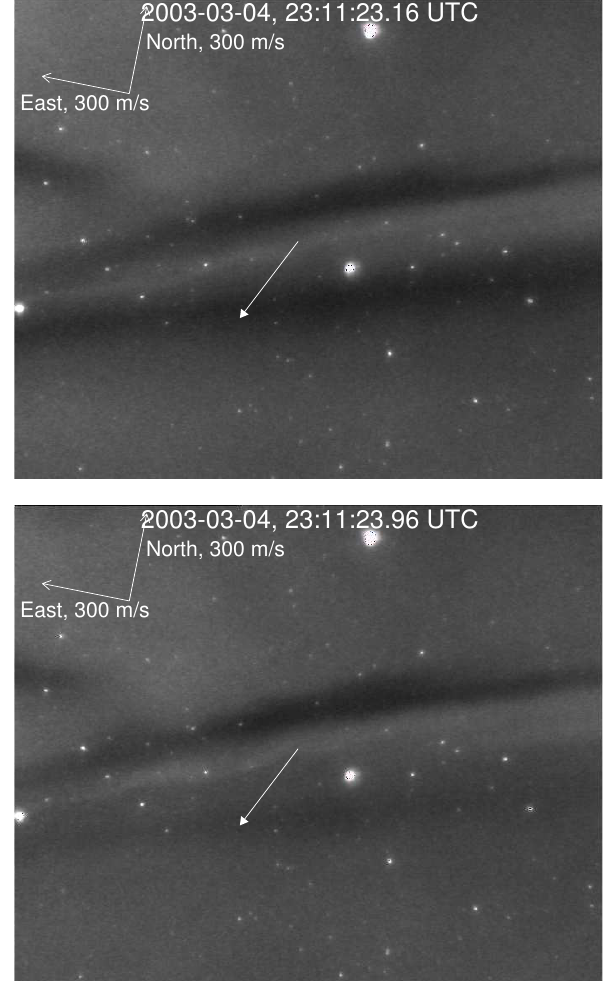
Fig. 6. Two images from event 03E, less than one second apart, showing the off (upper image) and on (lower image) phase of a pul- sating aurora which partially covers the southernmost black